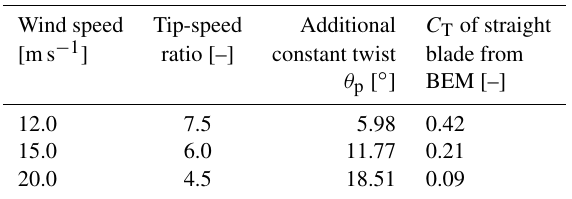
Table 3. The different operational conditions of the lower loading cases used for the